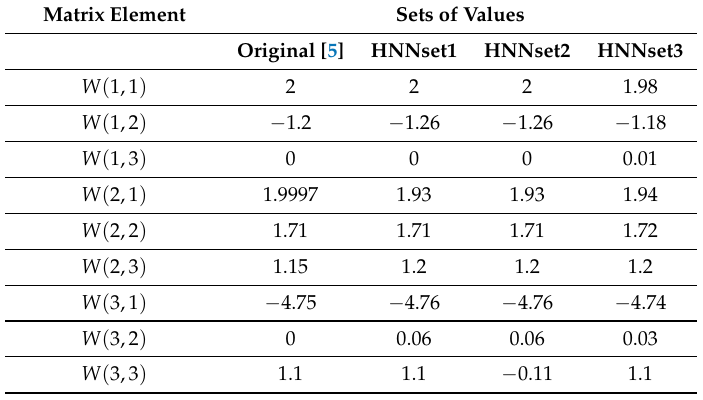
Table 2. Proposed sets of values to generate enhanced chaotic behavior using Hopfield neuron.